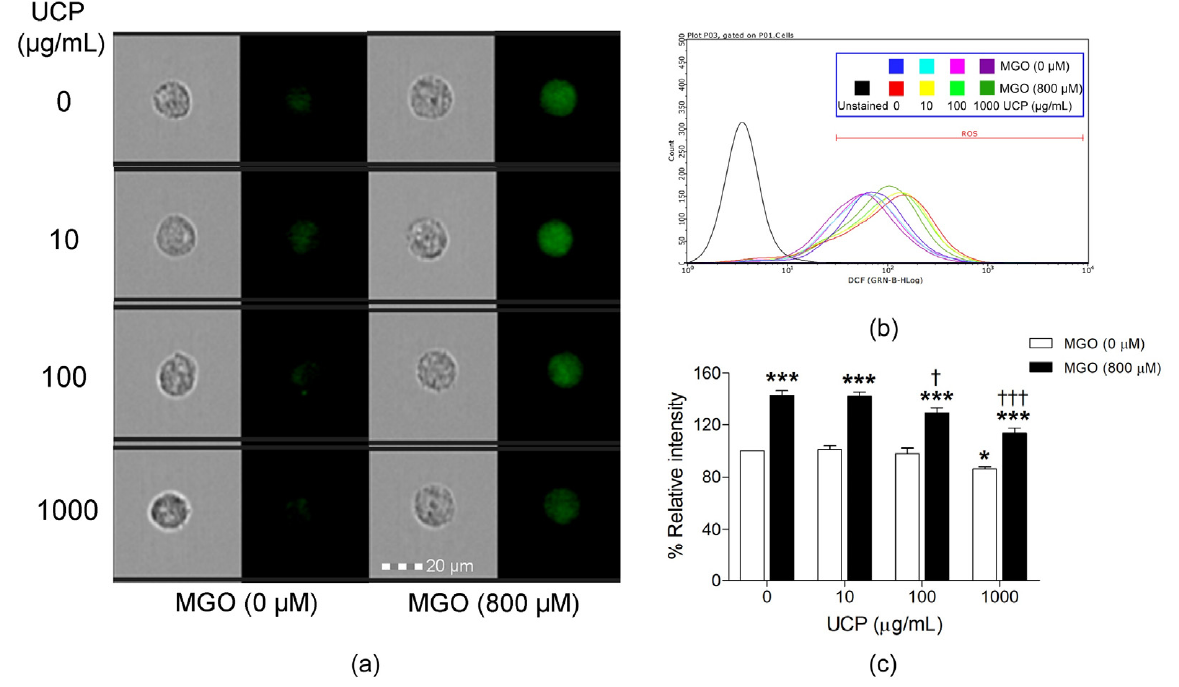
Figure 3. Effects of UCP pre-incubation on MGO-induced intracellular ROS production. ( a ) The representative photos of DCFH-DA green fluorescence probe detecting intracellular ROS in a single-cell configuration analyzed by imaging flow cytometer. ( b ) Flow cytometry histogram of relative intracellular ROS levels in each sample group. ( c ) A graphical representation of percent relative fluorescent intensity of cell populations in each treatment group. Data are presented as mean ± SEM of n ≥ 3. *, p <0.05; and ***, p < 0.001, when compared with the vehicle-treated group; †, p < 0.05; and †††, p < 0.001, when compared with MGO-treated group.